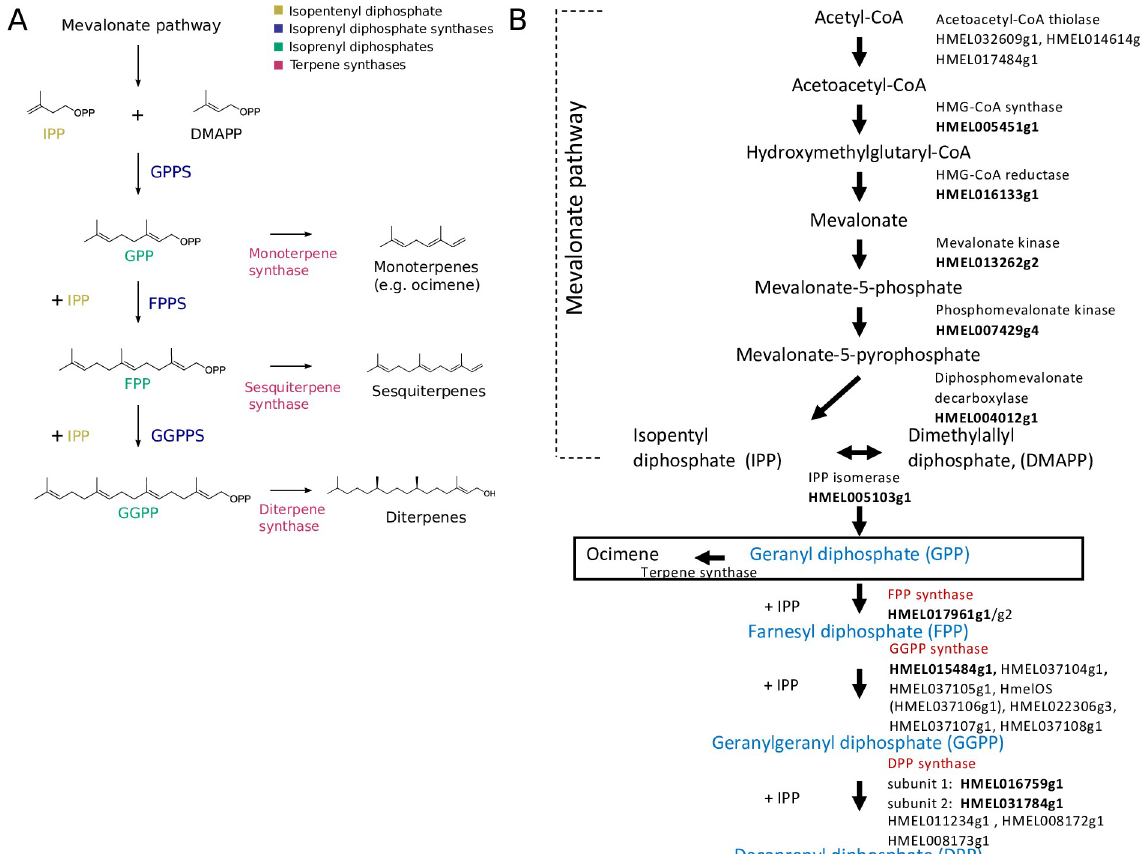
Fig 1. Pathway of terpene biosynthesis. (A) IPP and DMAPP are first formed from the mevalonate pathway. IPP and DMAPP are the substrates for isoprenyl disphosphate synthases (GPPS, FPPS, and GGPPS). IDSs produce isoprenyl diphosphates of varying lengths, depending on the number of IPP units added. Isoprenyl diphosphates (GPP, FPP, and GGPP) are themselves the substrates used by TPSs to make terpenes of various sizes. For example, monoterpene synthases produce monoterpenes, such as ocimene, from GPP. For illustration, ( E , E )- α -farnesene is used as a representative sesquiterpene, and phytol as a diterpene. (B) Proposed biosynthetic pathway in H . melpomene . Reciprocal best BLAST hits are highlighted in bold. IDSs are in red and their products, isoprenyl diphosphates, in blue. BLAST, basic local alignment search tool; DMAPP, dimethylallyl diphosphate; FPP, farnesyl diphosphate; FPPS, farnesyl diphosphate synthase; GGPP, geranylgeranyl diphosphate; GGPPS, geranylgeranyl diphosphate synthase; GPP, geranyl diphosphate; GPPS, geranyl diphosphate synthase; IDS, isoprenyl diphosphate synthase; IPP, isopentenyl diphosphate; TPS, terpene synthase.